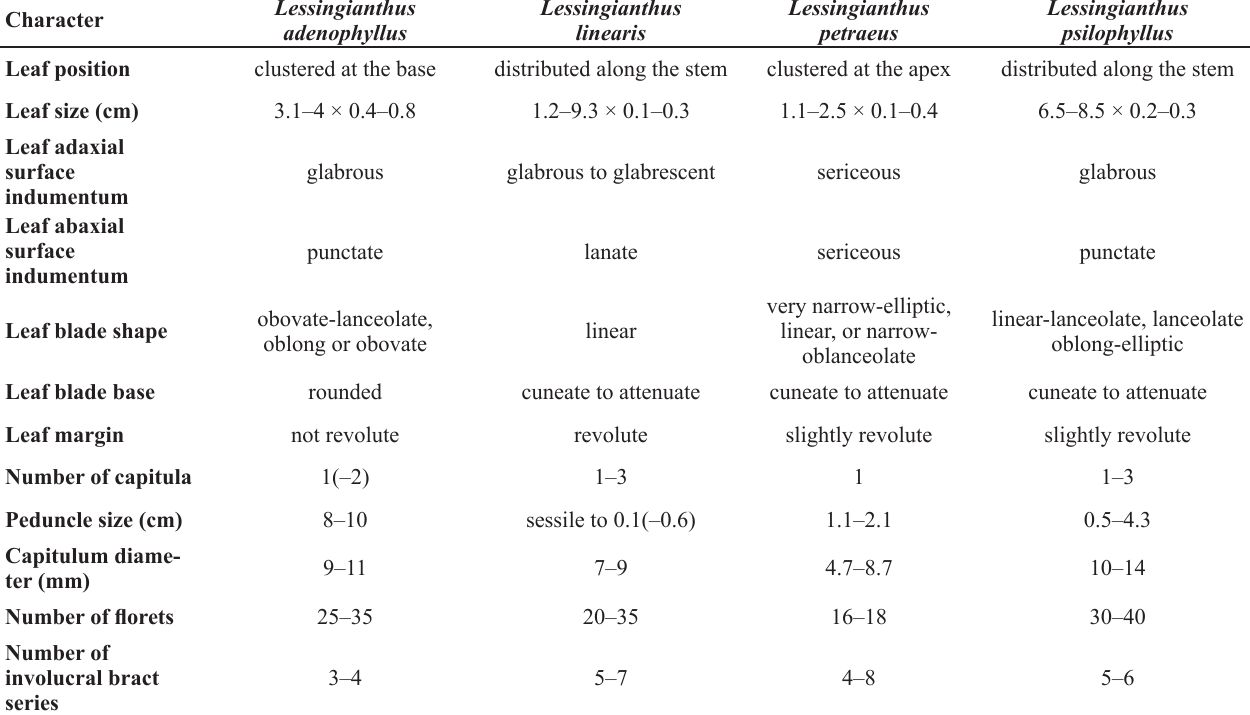
Table 2 – Diagnostic morphological characters of Lessingianthus petraeus and related